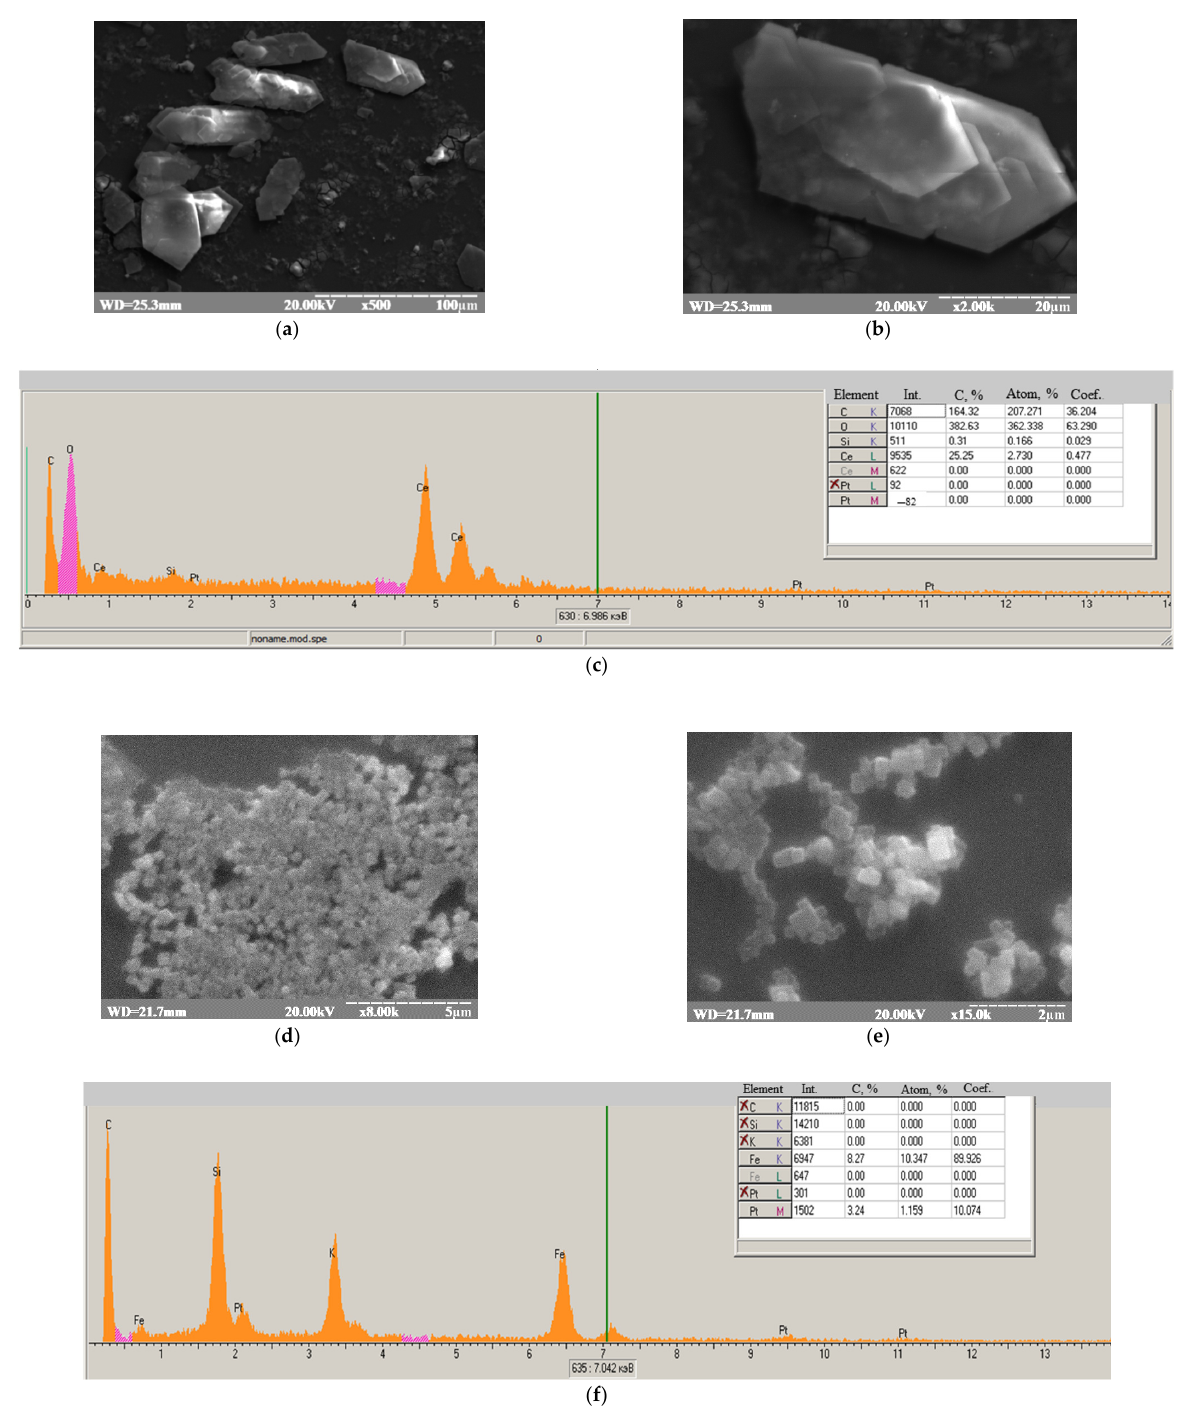
Figure 1. Characteristics of the nAuCePt ( a – c ) and nPtFe ( d – f ) NZs: SEM images ( a , b , d , e ); X-ray spectral microanalysis ( c , f ).